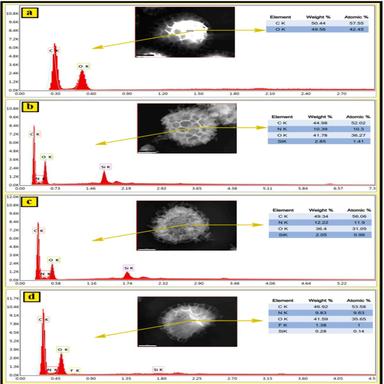
EDX analysis of (a) the pure Sp, (b) Sp-T, (c) Sp-TA and (d) the fluorescent Sp-TAB hybrid material.